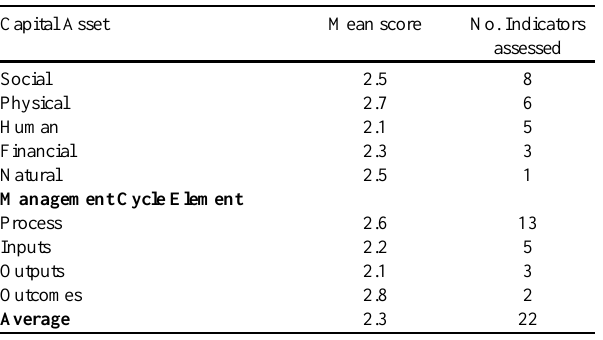
Fig. 2 . Indicator scores for four jointly managed parks in the Northern Territory, Australia, assessed January 2008 to October 2009 (green = very good; yellow = good; orange = not so good; red = bad; white = no